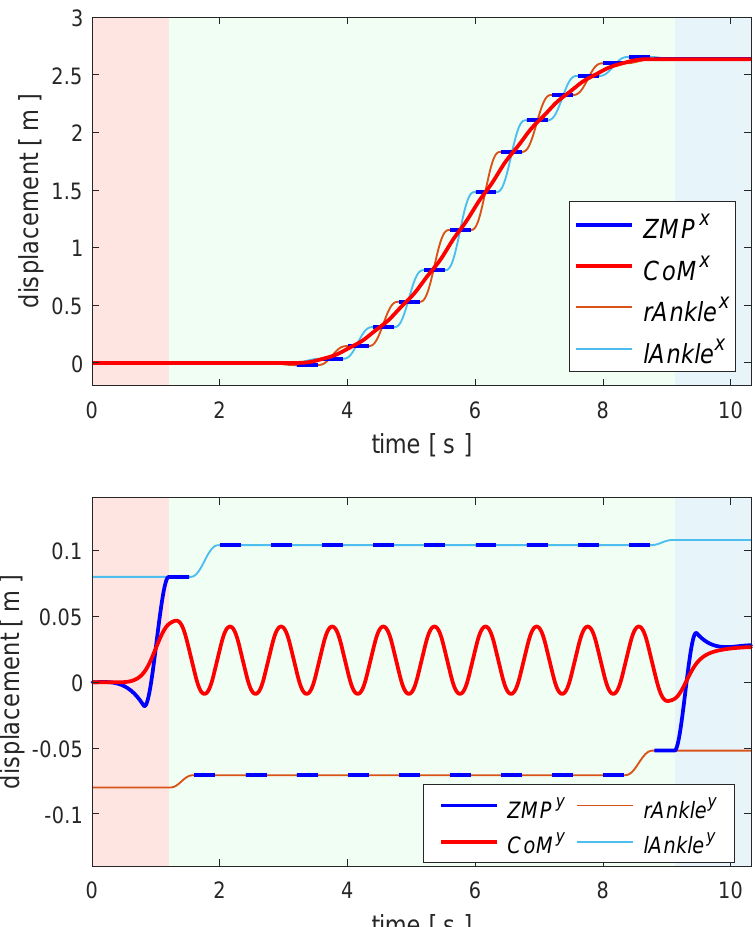
Figure 4. Trajectories of a complete running motion. Commanded forward speed increased first and then decreased, the maximal speed was 0.9 m/s, while the lateral speed changed periodically. The ZMP trajectories of State Switching 1 (red background) and 3 (blue background) were obtained with the NLP (16). The target footholds during the cyclic running (green background) were computed with Iterative Algorithm